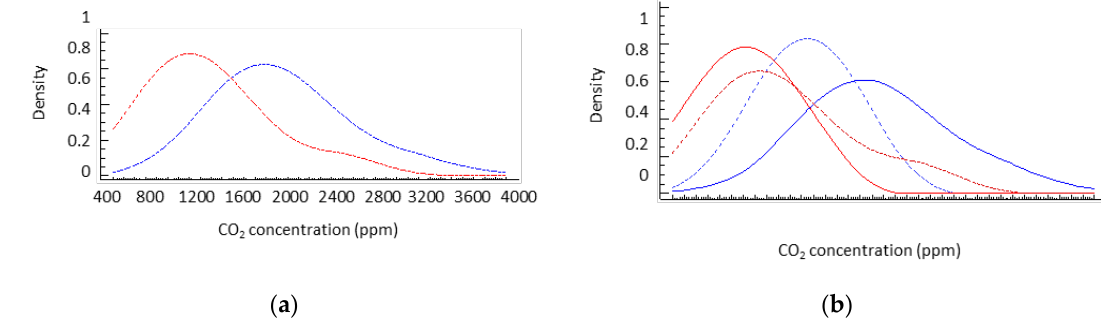
Figure 5. CO 2 concentration distribution. ( a ) General CO 2 concentration density trace for winter (blue) and mid-season (red). ( b ) Detailed CO 2 concentration density trace for winter (blue) and mid-season (red) with closed windows (continuous line) and windows open (dot line).